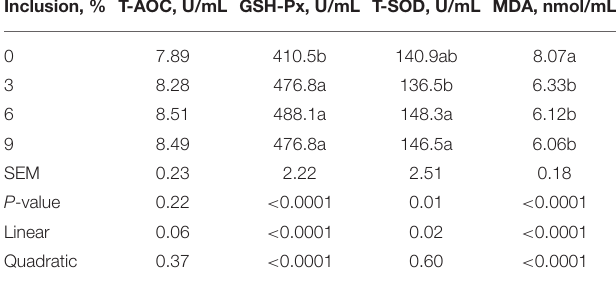
TABLE 6 | Effect of dietary low-inclusion levels of full-fatted black soldier fly larvae meal on the plasma antioxidant capacity of layer chickens at 42 days of age (each value represents the mean of six